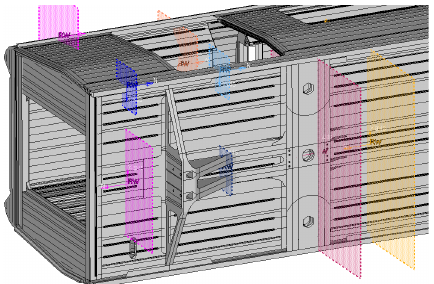
Figure 18. Section force-sensing unit position on the car body